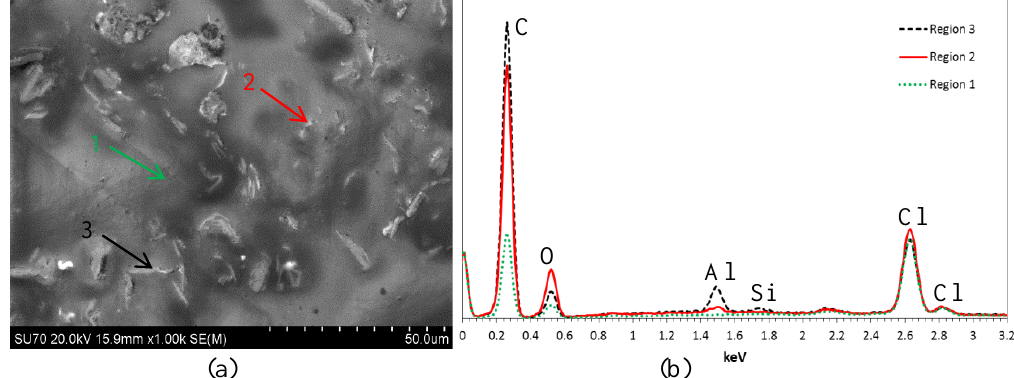
Figure 3. EDS data from 5 wt % CNP filled epoxy, depicting correct identification of rod shape CNP nanoclusters at Regions 2 and 3; ( a ) SEM image, ( b ) EDS data.